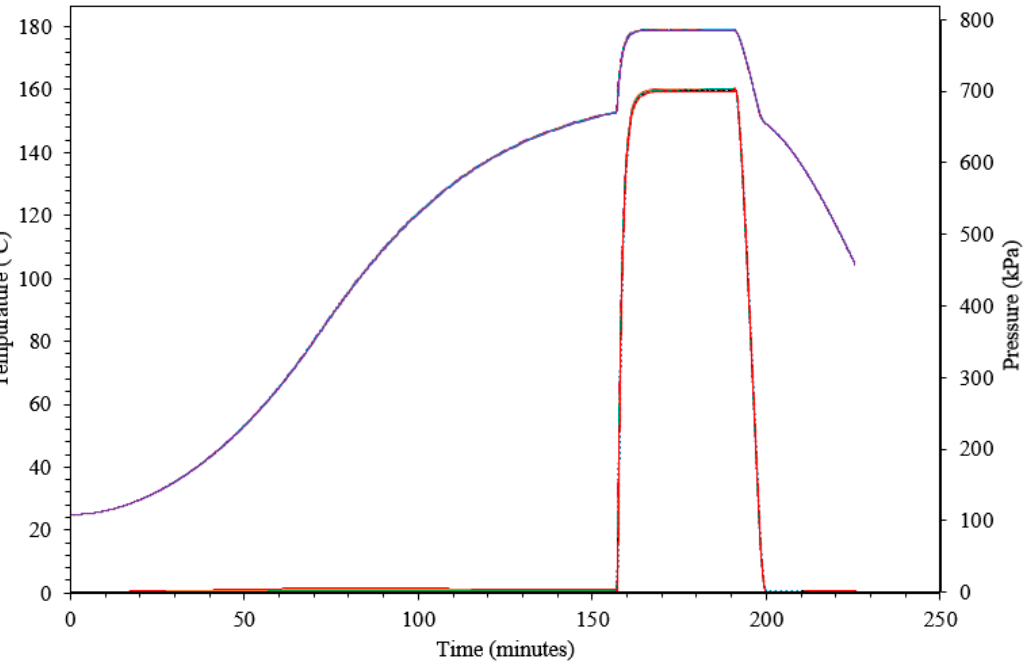
Figure 10. Internal rubber temperature ( violet ) and surface pressure ( red ) over the processing cycle time.